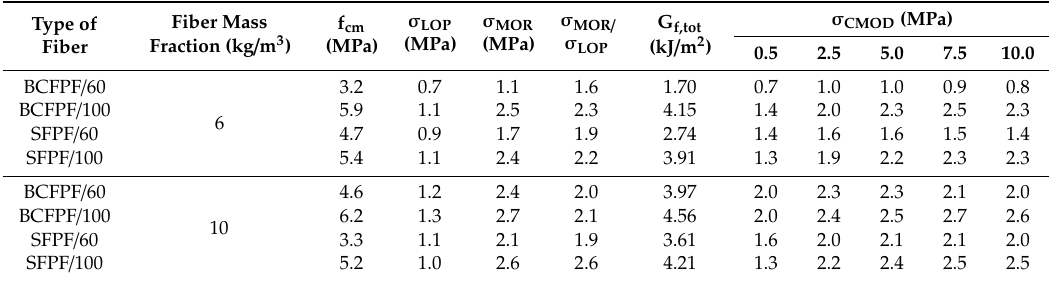
Table 5. Mechanical parameters of fiber-reinforced soil-cement with 400 / 1.6 matrix after 28 days of curing.